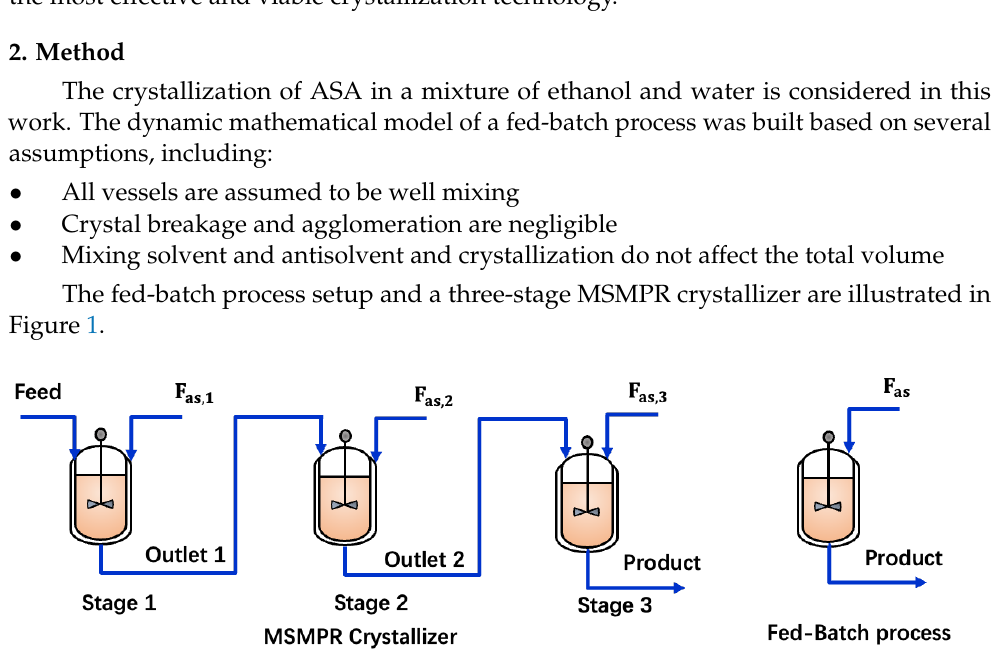
Figure 1. The setup of fed-batch crystallizer and multistage MSMPR crystallizer.